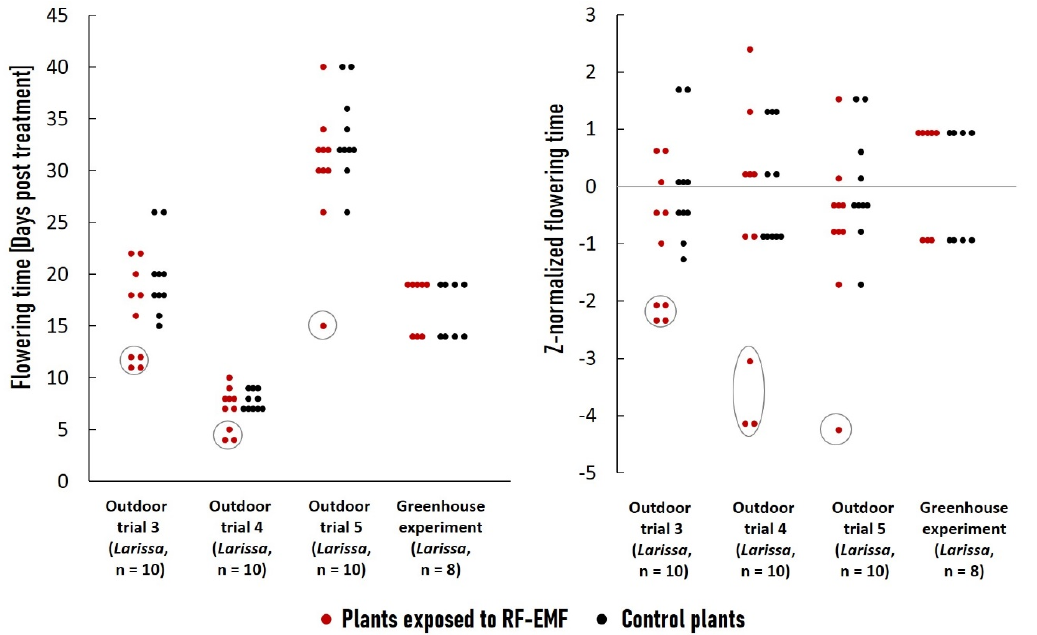
Figure 5. Flowering time comparison of plants continuously exposed to RF-EMF and controls. In total, there were 3 independent experiments under outdoor conditions (outdoor 1, 2, 3) and one under indoor conditions (greenhouse), each with equal numbers (8–10) plants from each group. The dots represent flowering time of individual plants. ( Left ) Flowering time (days after experiment onset). ( Right ) Normalized flowering time based on the mean and standard deviation of the control group’s data (Z-scores). The subsets of treated plants that began flowering substantially earlier than the rest of the group and plants in the control group are indicated by circles.